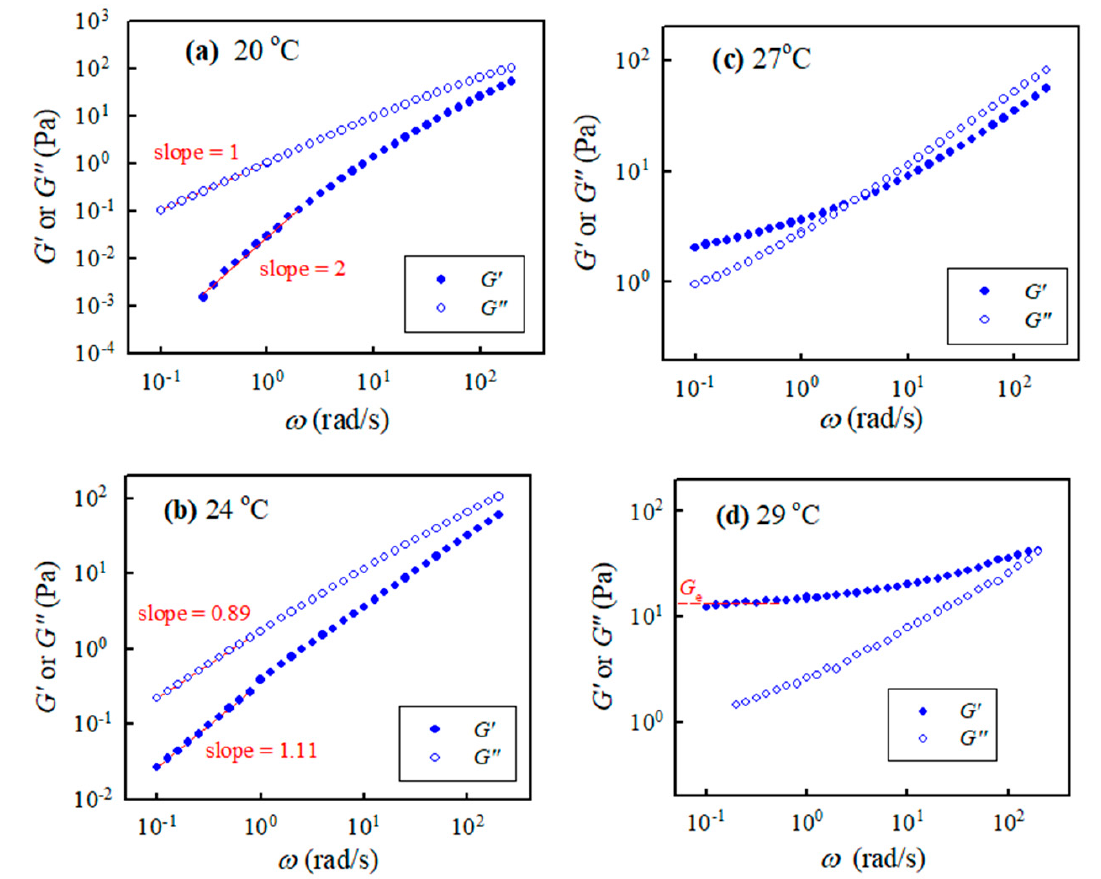
Figure 4. Storage modulus and loss modulus of the 10 wt% a-PNIPAM/H 2 O vs. applied frequencies at different temperatures of ( a ) 20, ( b ) 24, ( c ) 27 and ( d ) 29 °C. At the gel point (GP), the dynamic modulus of G (cid:48) and G” exhibit a power law frequency dependence